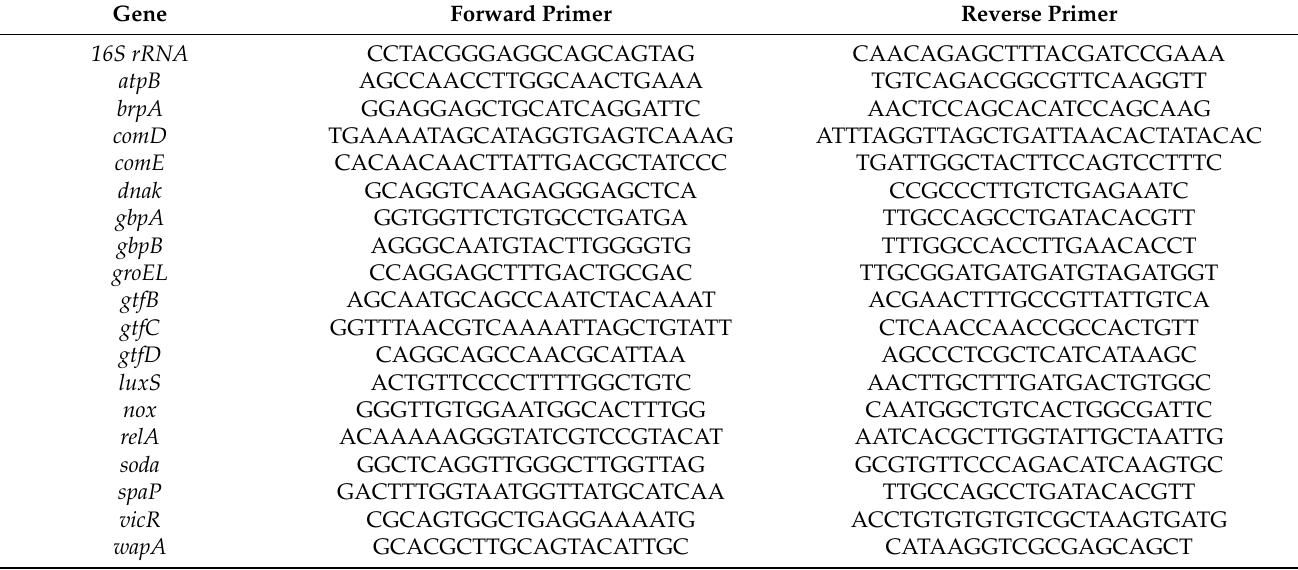
Table 1. Primers used for real-time